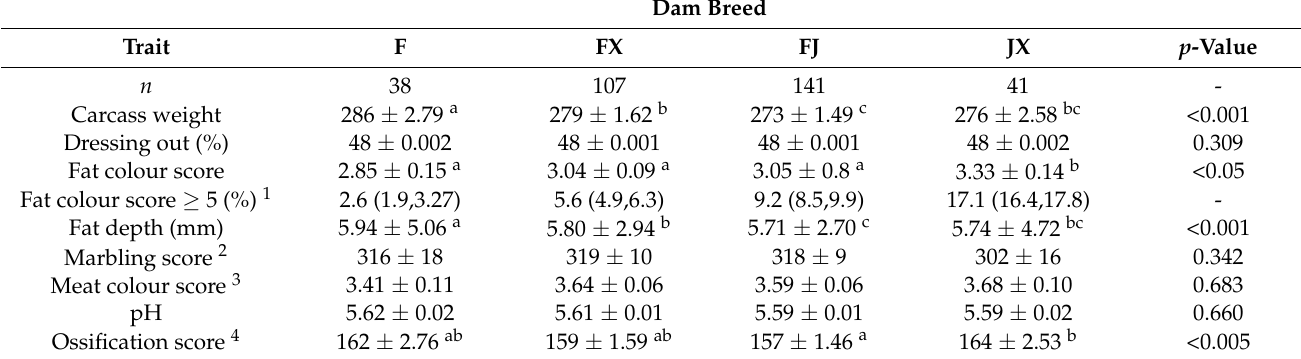
Table 4. Carcass characteristics for beef-cross-dairy-breed progeny from Friesian (F), Friesian-cross (FX), Friesian–Jersey (FJ) and Jersey-cross (JX) dams. Values are least squared means, ± standard error of the mean. Dam